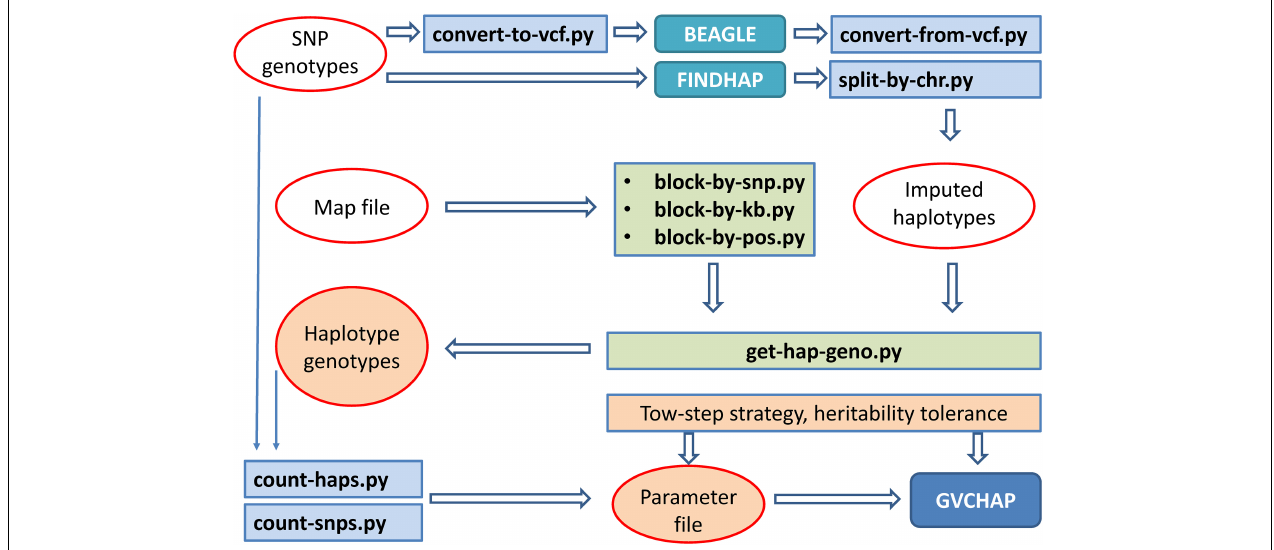
FIGURE 2 | Computing pipeline for preparing input files for GVCHAP analysis.